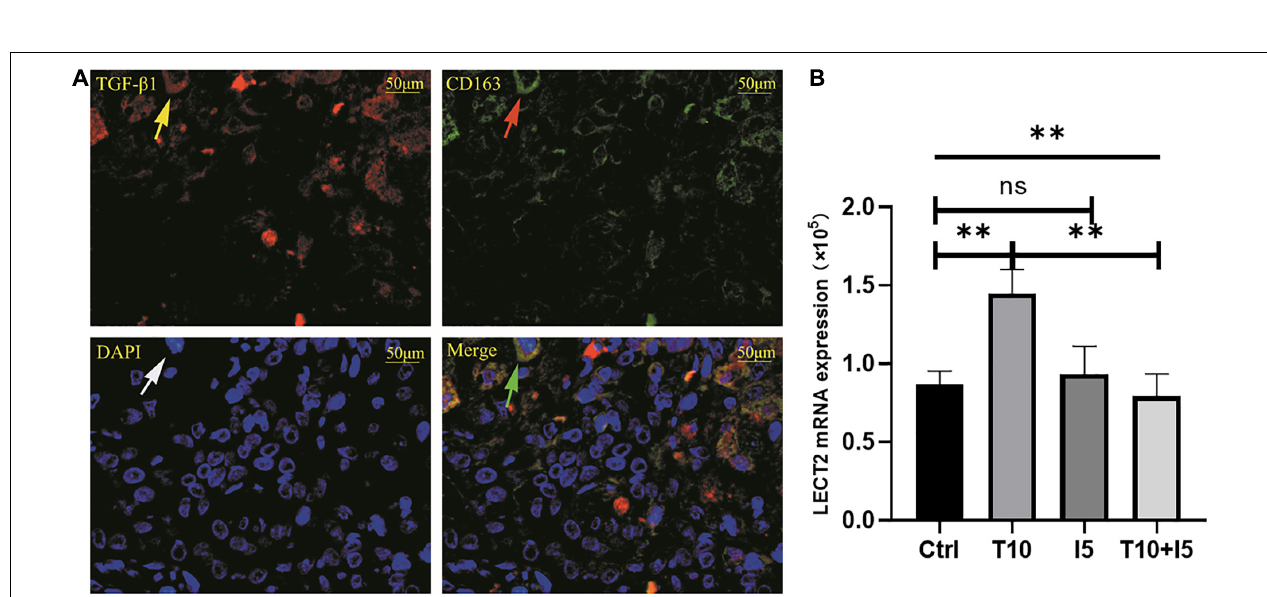
FIGURE 6 | (A) TGF- β 1 and CD163 were co-localized in BA livers. (B) rhTGF β 1 upregulated the expression of LECT2. (A) The red fluorescence indicated by the yellow arrow is TGF- β 1, CD163 was labeled by green fluorescent indicated by the red arrow, all nucleus were blue fluorescent indicated by the white arrow. The green arrow points to the merge of TGF- β 1 and CD163. (B) The human normal liver cells (L02) were conducted in vitro and divided into four groups, namely, Ctrl, T10, I5, and T10 + I5. The differences among the four groups were statistically significant by one-way ANOVA. In other words, rhTGF β 1 upregulated the expression of LECT2. However, the effect was reversed with the use of LECT2 blocker ICG001. LECT2, leukocyte cell-derived chemotaxin 2; Ctrl, blank control group; T5, rh TGF- β 1 5 ng/ml; T10, rh TGF- β 1 10 ng/ml; I5, ICG 001 5 mg/ml; T10 + I5, rh TGF- β 1 10 ng/ml + ICG 001 5 mg/ml. ∗∗ p < 0.01.